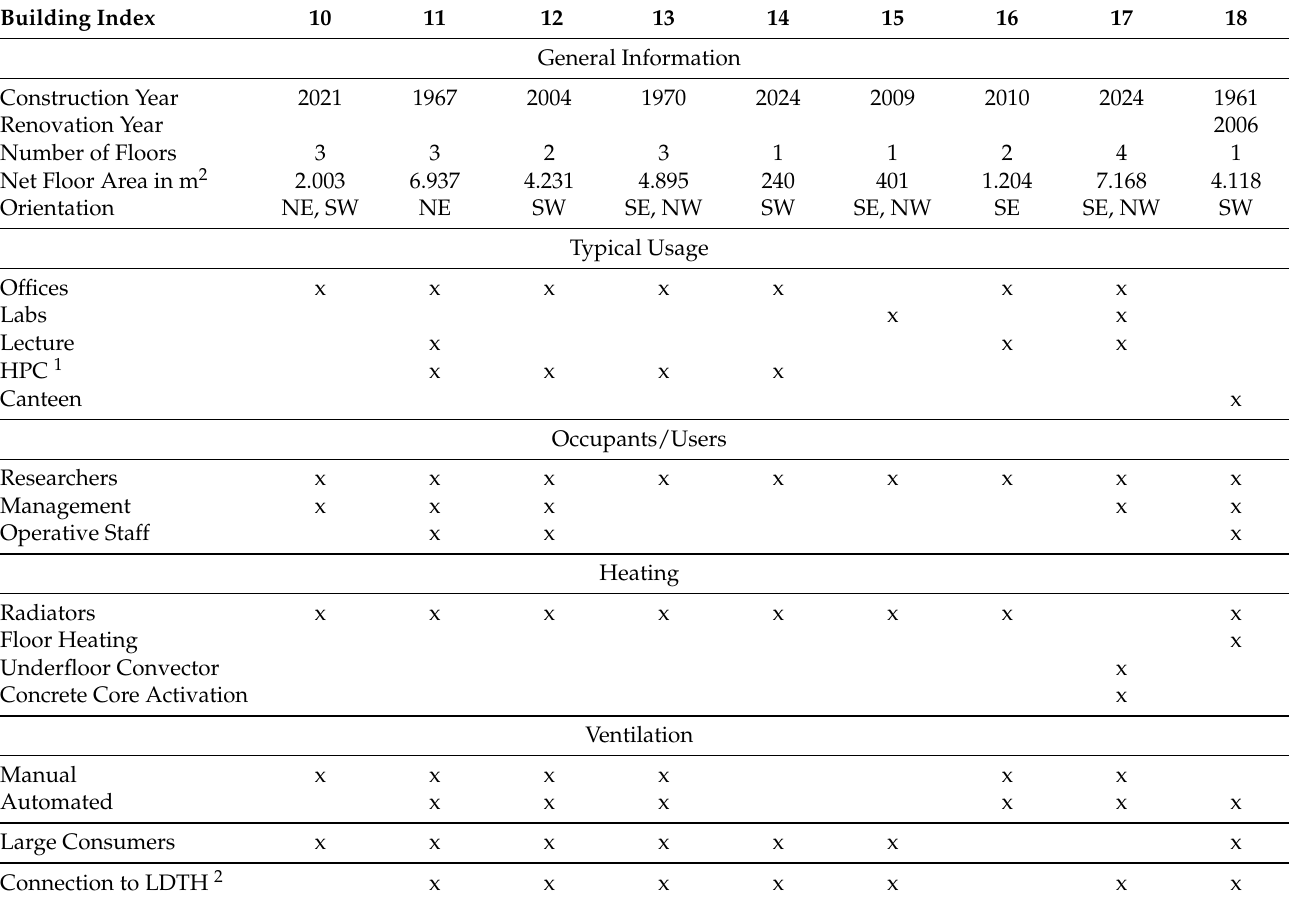
Table 3. Further buildings to be equipped (Group